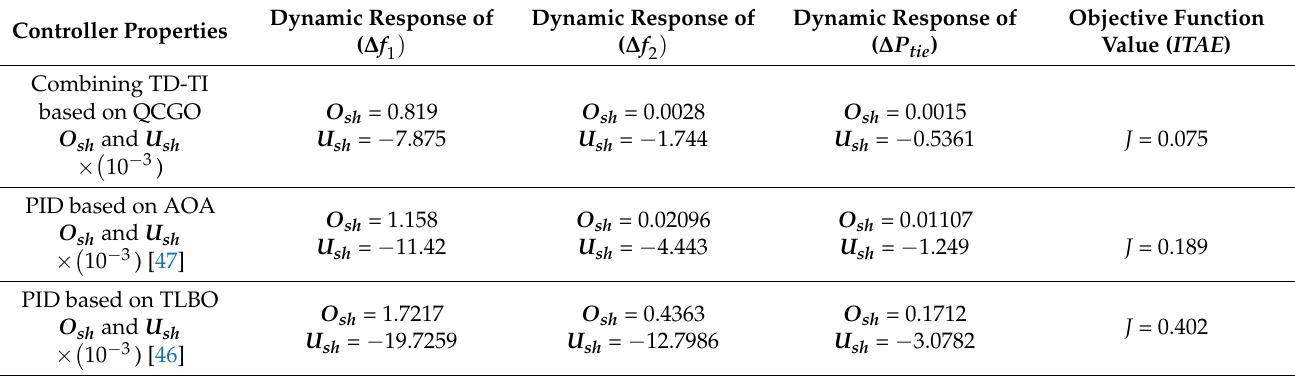
Table 8. The transient response specifications of the presented system for case A.1.1.